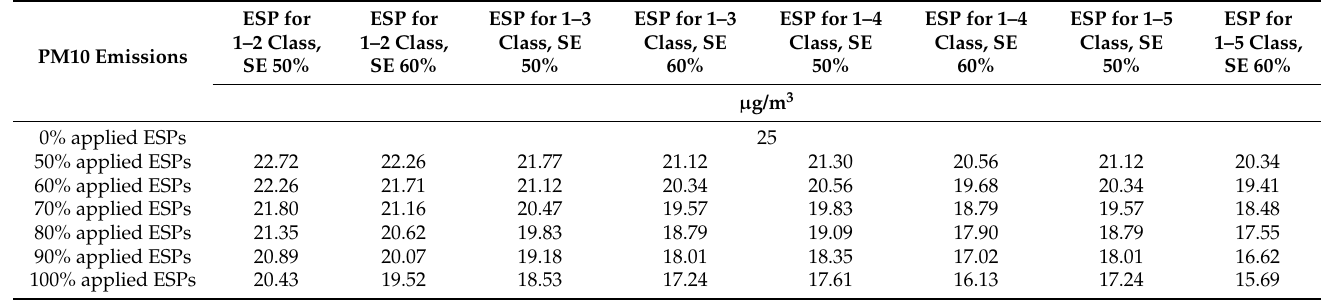
Table 3. Average annual PM10 concentrations in the air of the model village.